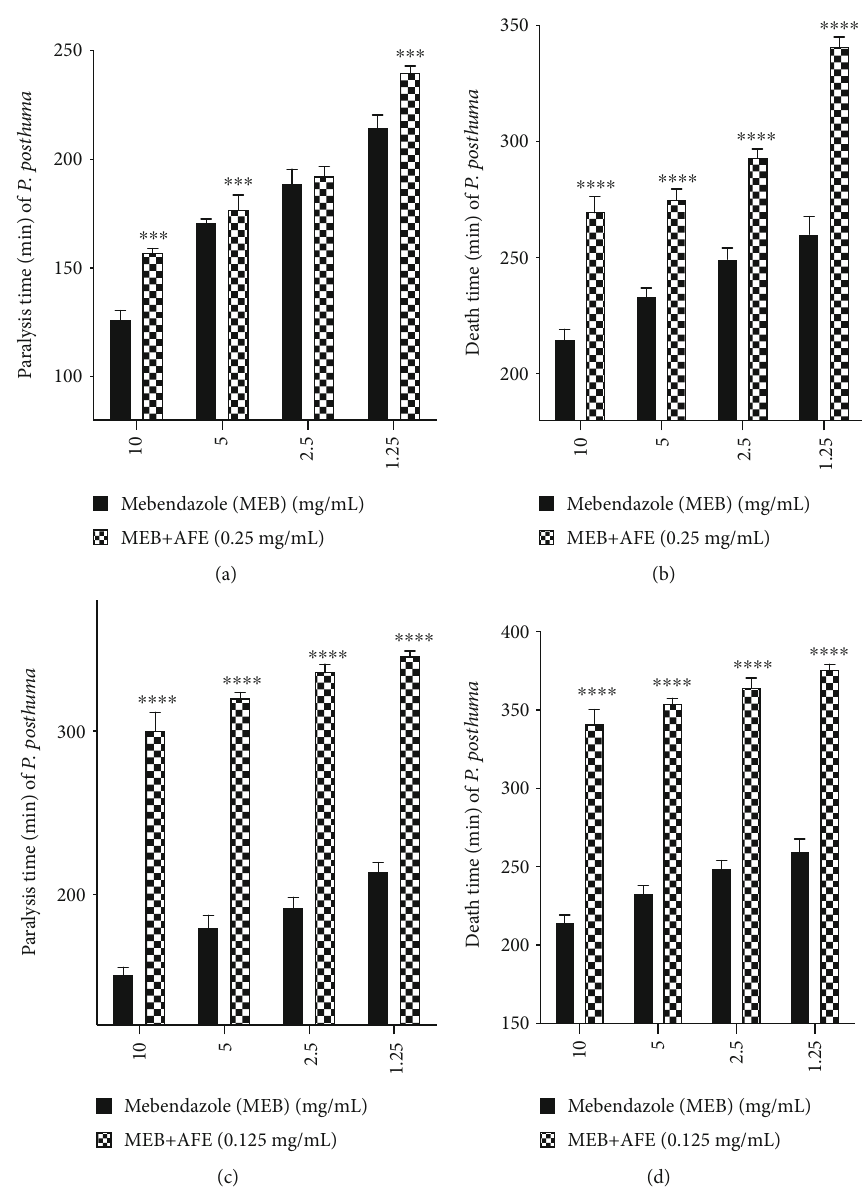
Figure 4: E ff ect of AFE on paralytic and helminthicidal activity of mebendazole. (a, b) E ff ect of 0.25mg/mL AFE on mebendazole.(c, d) E ff ect of 0.125 mg/mL AFE on mebendazole. MEB: mebendazole; AFE: A. ferruginea ethanol stem bark extract; ∗∗∗∗ p < 0 : 0001 , ∗∗∗ p < 0 : 001 compared to the control (one-way ANOVA followed by Dunnett ’ s post hoc